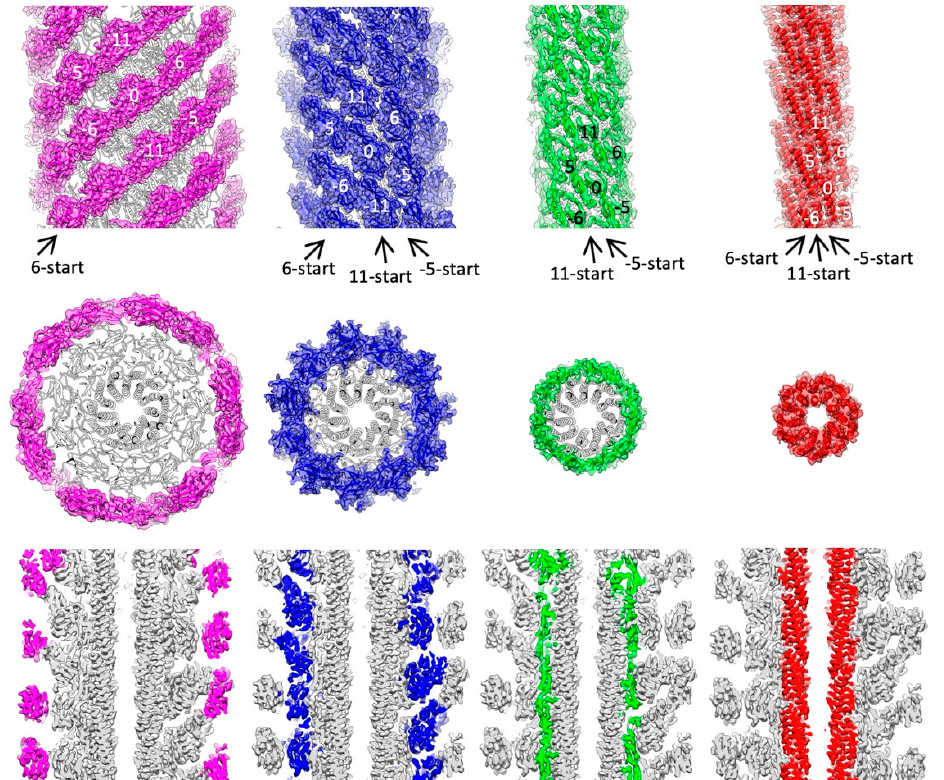
Figure 1. Structures and spatial arrangements of FlgE domains in the hook. The 3D density map and ribbon diagram of the atomic model are presented in different views and slices to visualize the structure and helical array of each of the four domains in different colors: D2, magenta; D1, blue; Dc, green; and D0, red, from left to right panels. The side views are shown in the upper panels, end-on views in the middle, and central slices along the hook axis in the lower. The diameters of these domain arrays are 172 Å, 142 Å, 85 Å, and 62 Å, respectively. The start numbers of the three major helical lines are labeled with arrows in the side views.